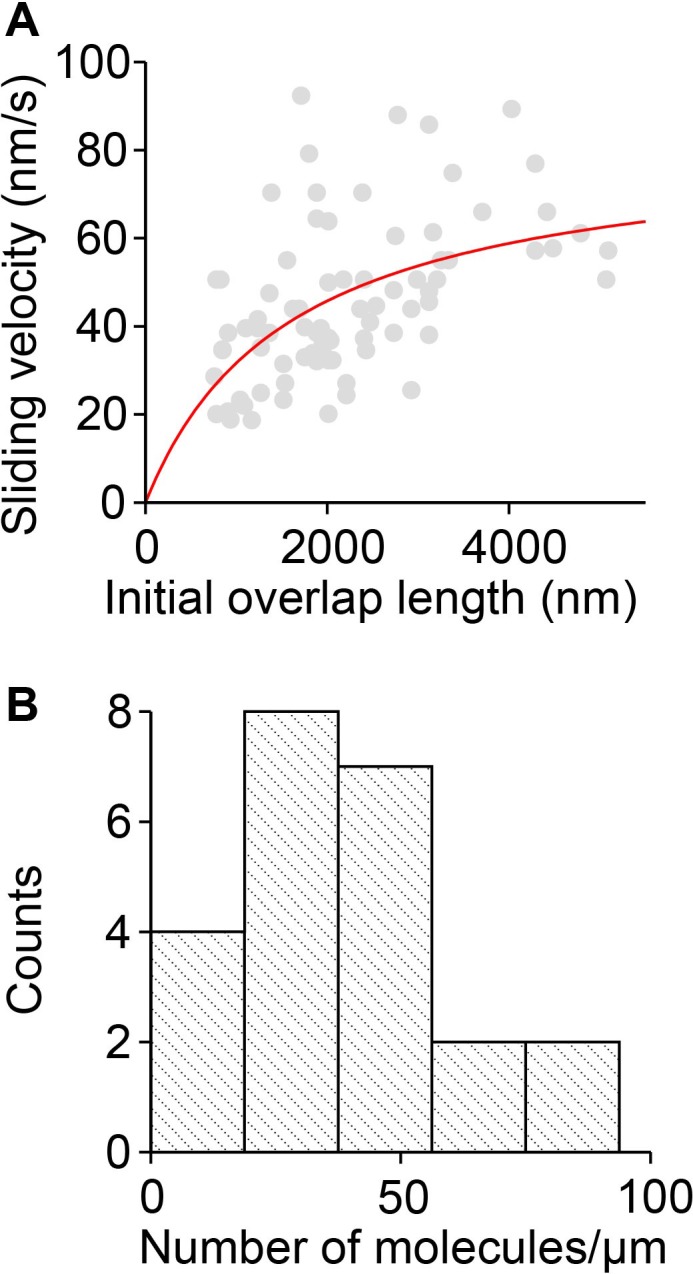
Estimation of the sliding efficiency of PRC1-Kif4A molecules.(A) The fitting of Equation 1 (red line) to the microtubule sliding velocity as a function of initial microtubule overlap length data (Assay condition: 0.2 nM PRC1 + 6 nM Kif4A-GFP (gray circles; N = 83). (B) Estimation of the number of molecules/µm from experimental fluorescence intensity measurements.10.7554/eLife.32595.032Figure 8—figure supplement 2—source data 2.This spreadsheet contains the microtubule sliding velocity versus the initial microtubule overlap length data used to generate the scatter plot in Figure 8—figure supplement 2A and the estimation of the number of molecules/µm used to generate the histogram in Figure 8—figure supplement 2B.